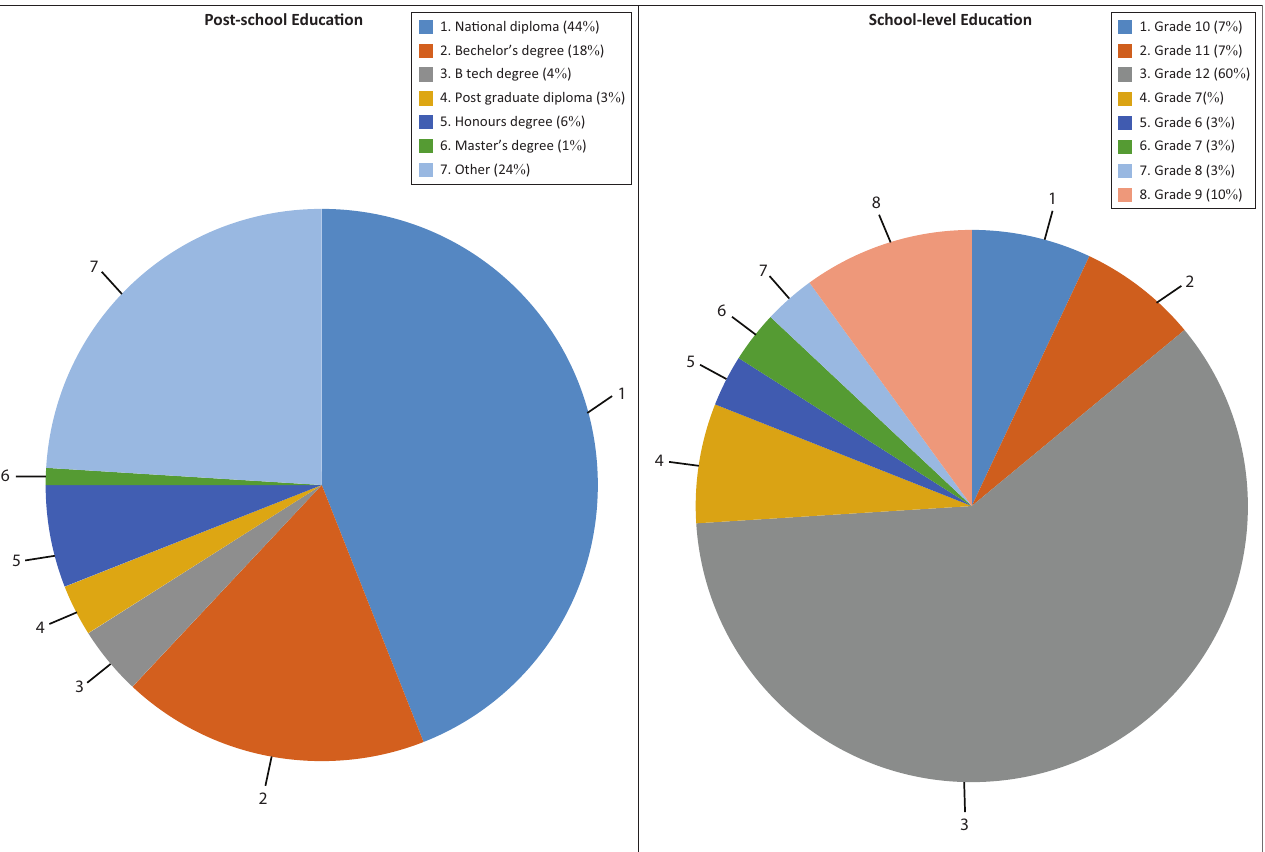
FIGURE 1: Demographic comparisons by education level. TABLE 1: Summary of descriptive statistics of the scale.